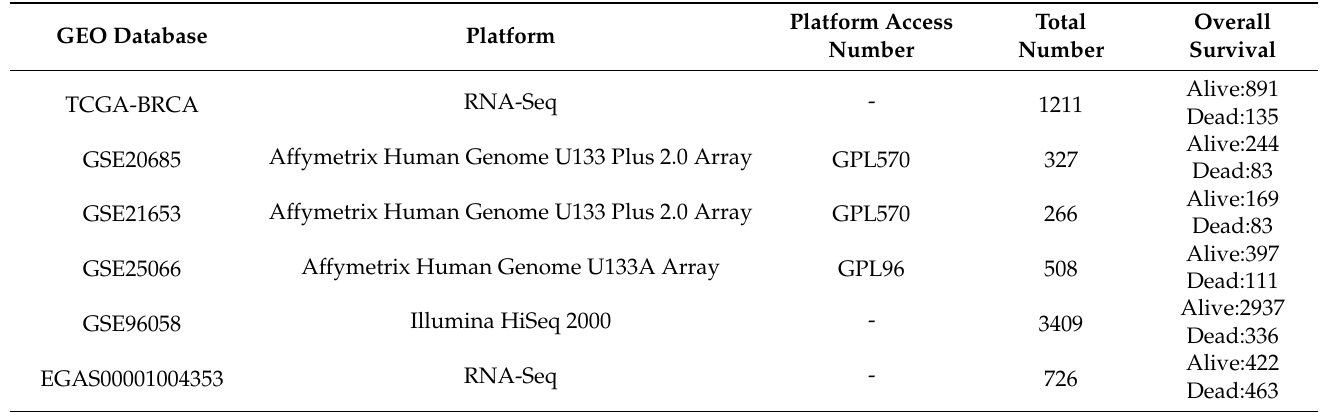
Table 4. The details of database and survival outcomes in this